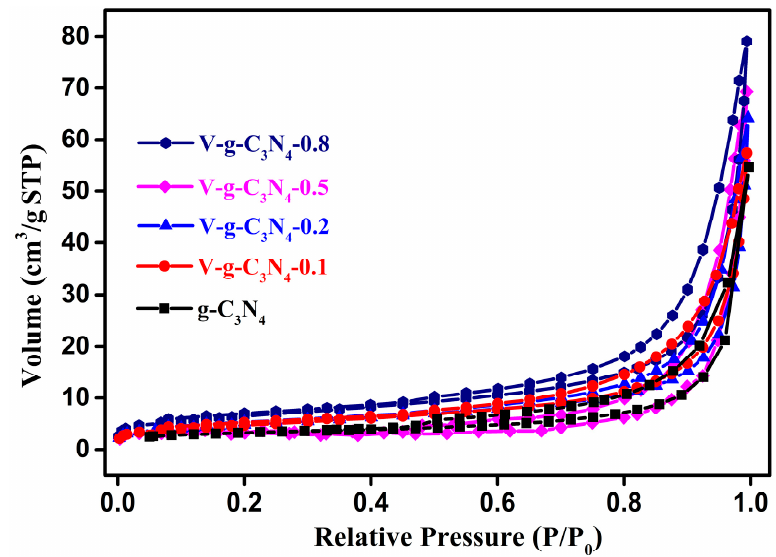
Figure 9. N 2 sorption isotherms of the g ‐ C 3 N 4 and V ‐ doped g ‐ C 3 N 4 samples.